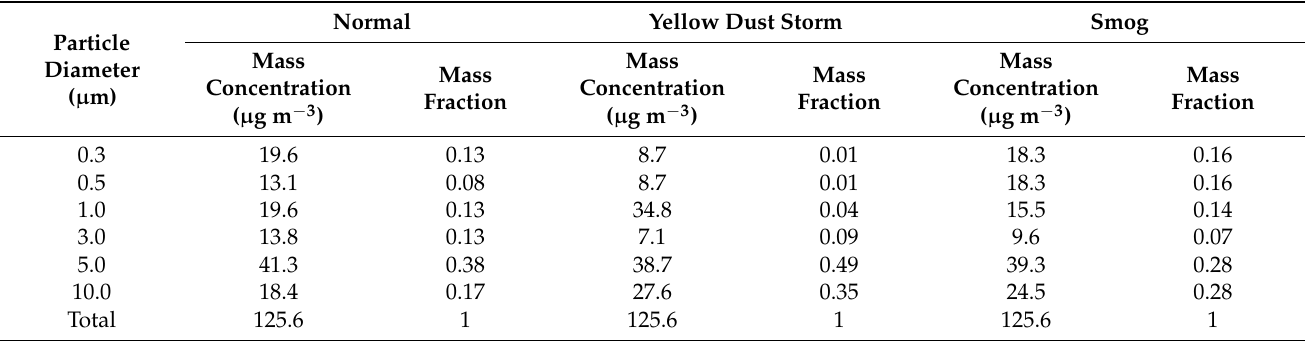
Table 3. Distributions of size-resolved outdoors particle